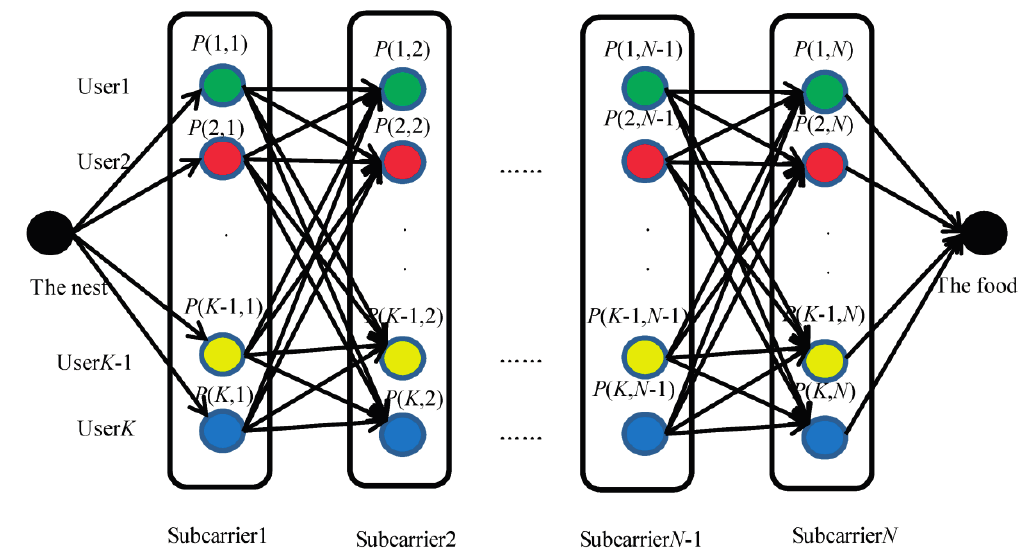
Figure 2. The structure diagram of subcarrier allocation by ant colony optimization (ACO)